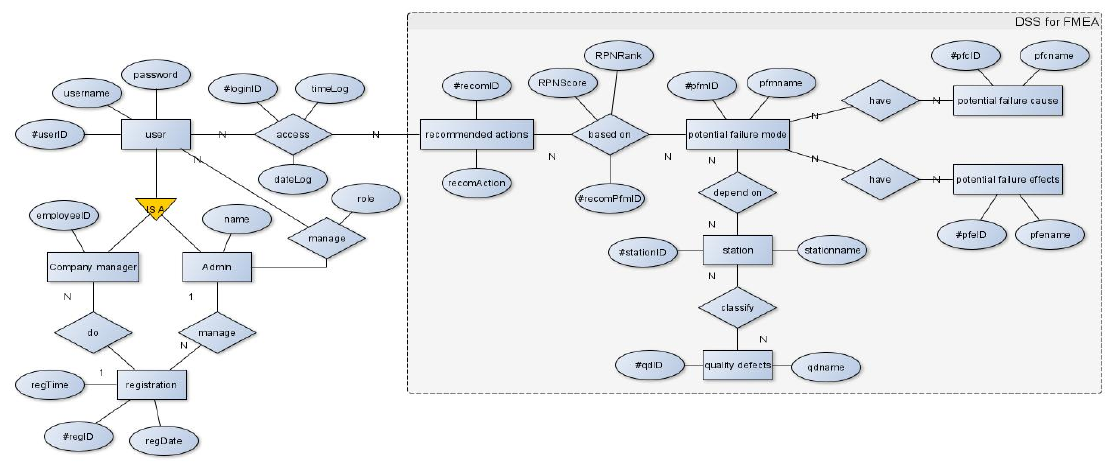
Figure 6. Entity Relationship Diagram (ERD) for the System Database.